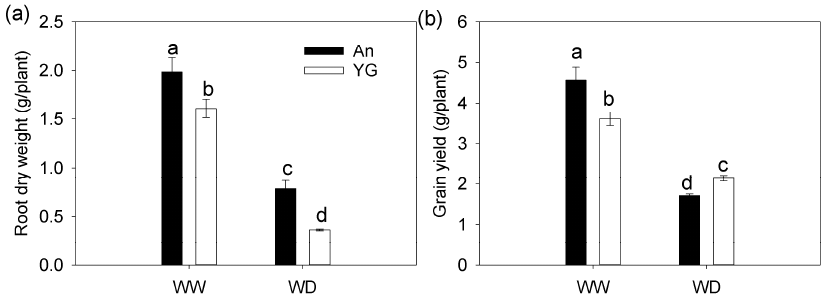
5 of 14 Figure 1. Effect of soil water status on the ( a ) root exudation and leaf photosynthetic parameters, ( b ) net photosynthesis rate, ( c ) stomatal conductance, ( d ) and transpiration rate of the two cultivars at the flowering state. The different letters represent significant differences of WD, WW, An and YG ( p < 0.05). 3.2. Root Biomass and GY The water stress significantly decreased the RDM of the two cultivars in the flower-